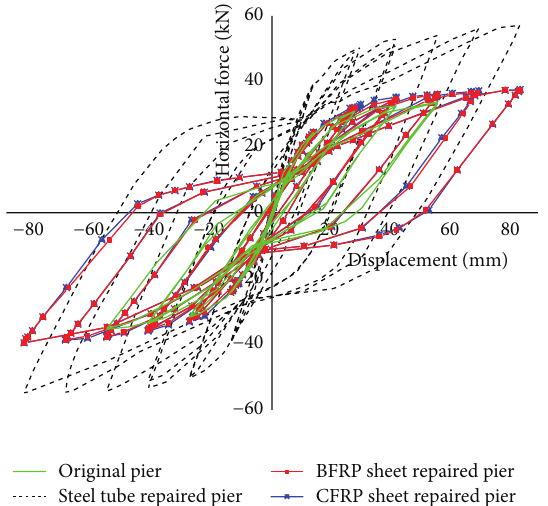
Figure 13: Comparisons of the hysteretic curves obtained from FE analysis.